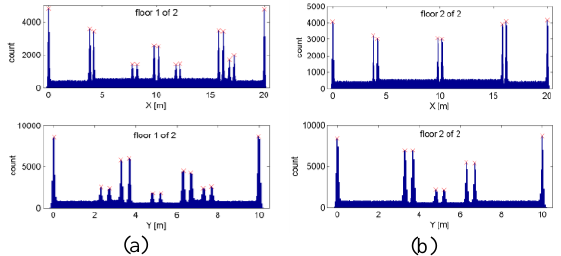
Figure 5. The histograms of x - and y coordinates for each floor showing distinct peaks corresponding to the location of walls and size of subspaces.